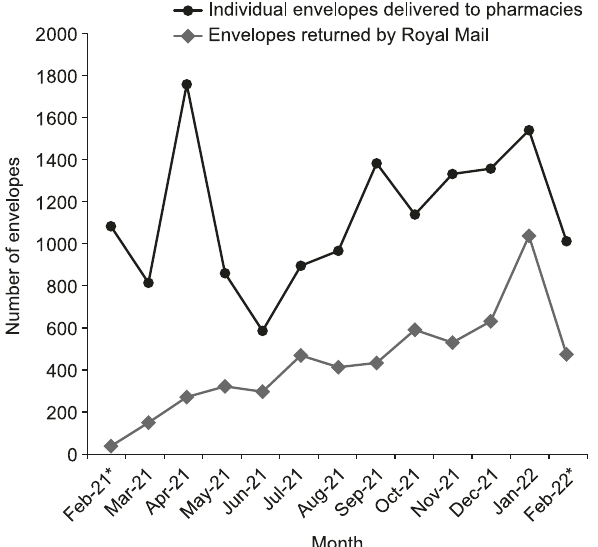
Fig. 3 Envelopes delivered to pharmacies and envelopes returned by Royal Mail in each month. *February 2021 and February 2022 data include only 2 weeks of the month.